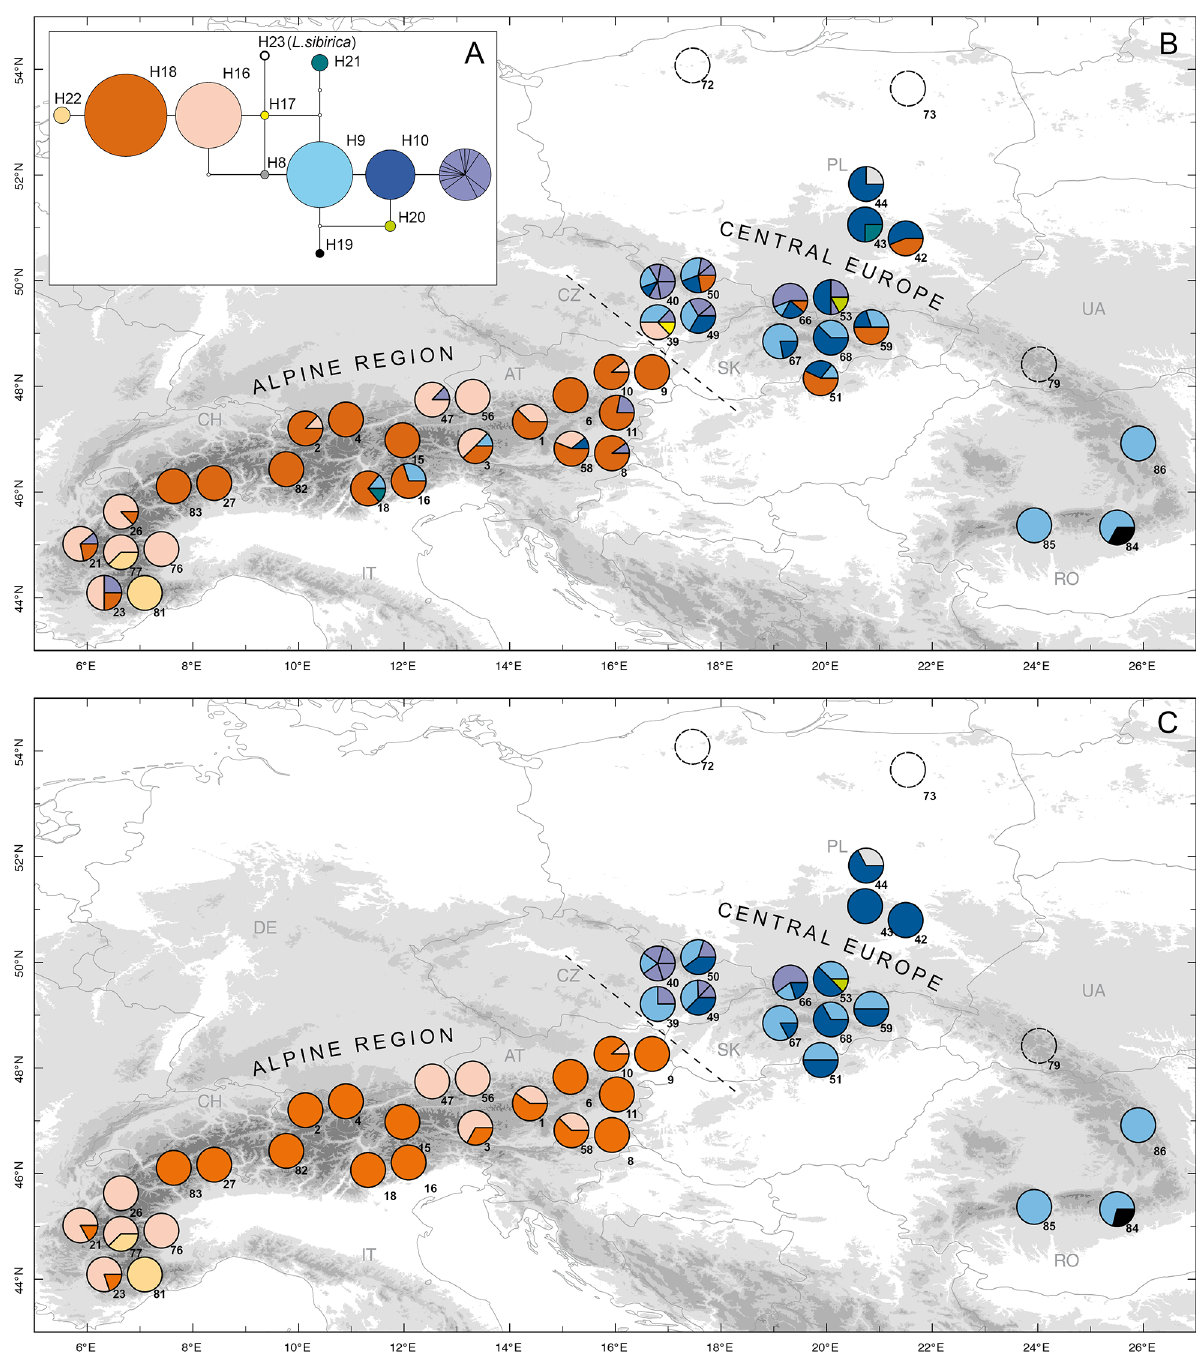
Fig 1. Results of mitochondrial analyses. Minimum spanning network (A), distribution of combined mitochondrial haplotypes before (B) and after (C) translocation removal. In (A) circles represent haplotypes colored by their codes and scaled to their frequencies. Haplotypes caused by minisatellite variation are in purple. White circles correspond to predicted haplotypes that were not observed. Branches correspond to single mutations regardless of their length. In (B) and (C) circles represent the haplotype composition of the 40 presumably native populations and three populations sampled outside the range (n°72, 73 and 79) (~8